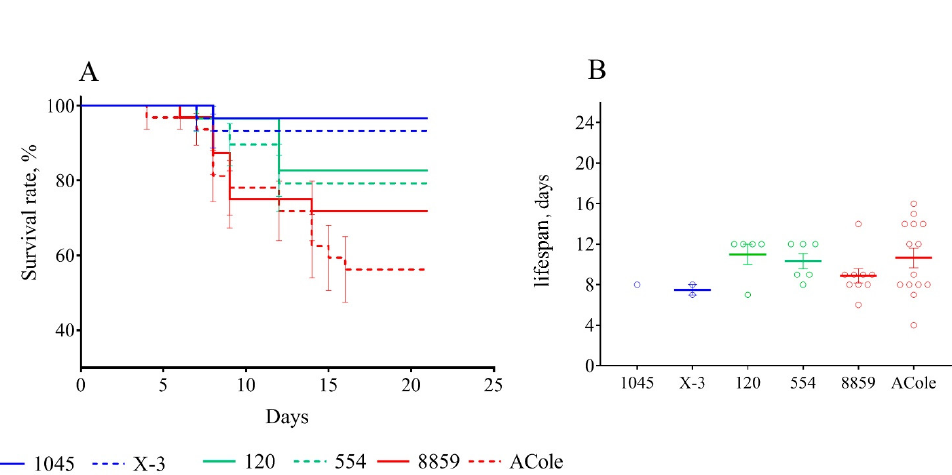
Table 3. Mortality rate and lifespan of mice immunized 90 days before the experiment and infected with 6 virulent strains of F. tularensis . Values are indicated with the standard error of the mean (SEM). Strain Subspecies Mortality Rate, % Average Lifespan, days